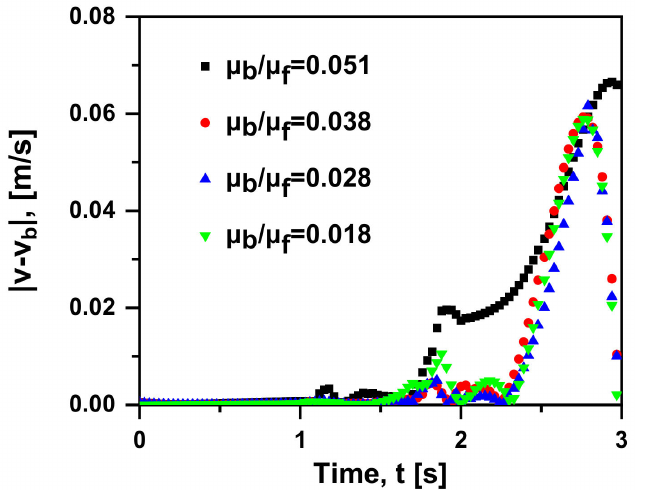
Figure 12. Absolute difference in rising velocity between the case with and without Basset force at four viscosity ratios ( v 0 = 0 m/s, d b = 1 mm, ρ f = 1000 kg/m 3 , ρ b = 1.29 kg/m 3 in quiescent